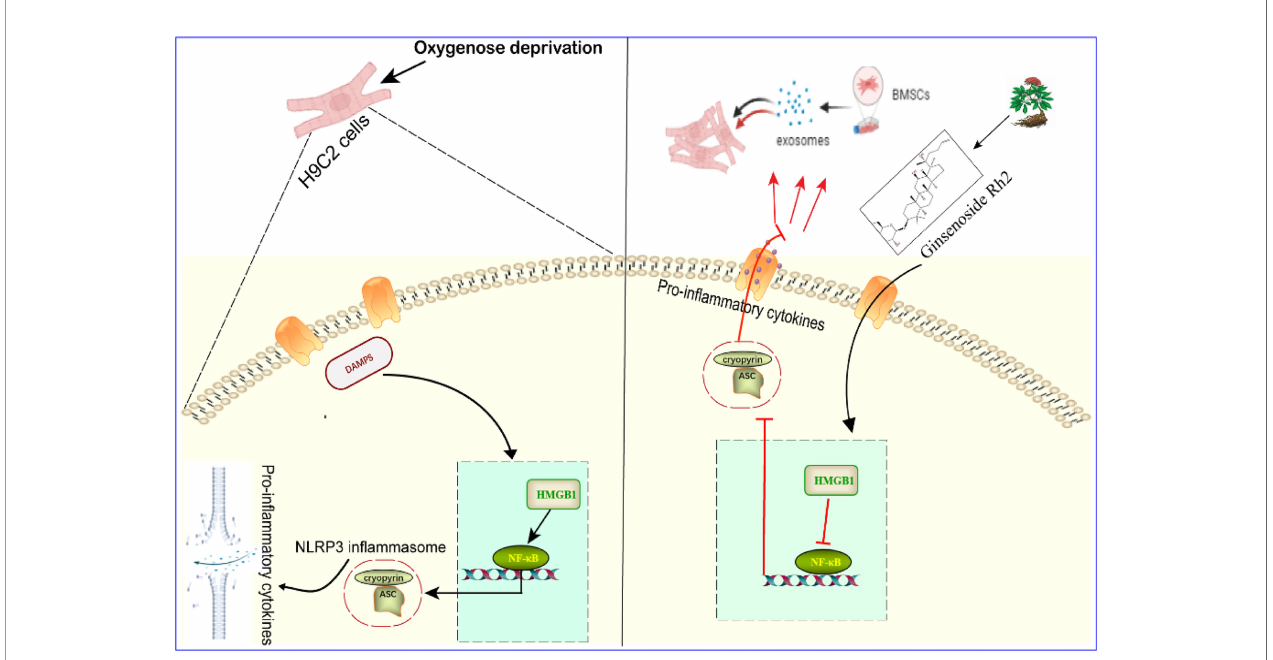
FIGURE 7 | Effect and mechanism of Ginsenoside Rh2 promoted BMSC-derived exosomes in the treatment of cardiomyocyte injury under oxygen glucose deprivation